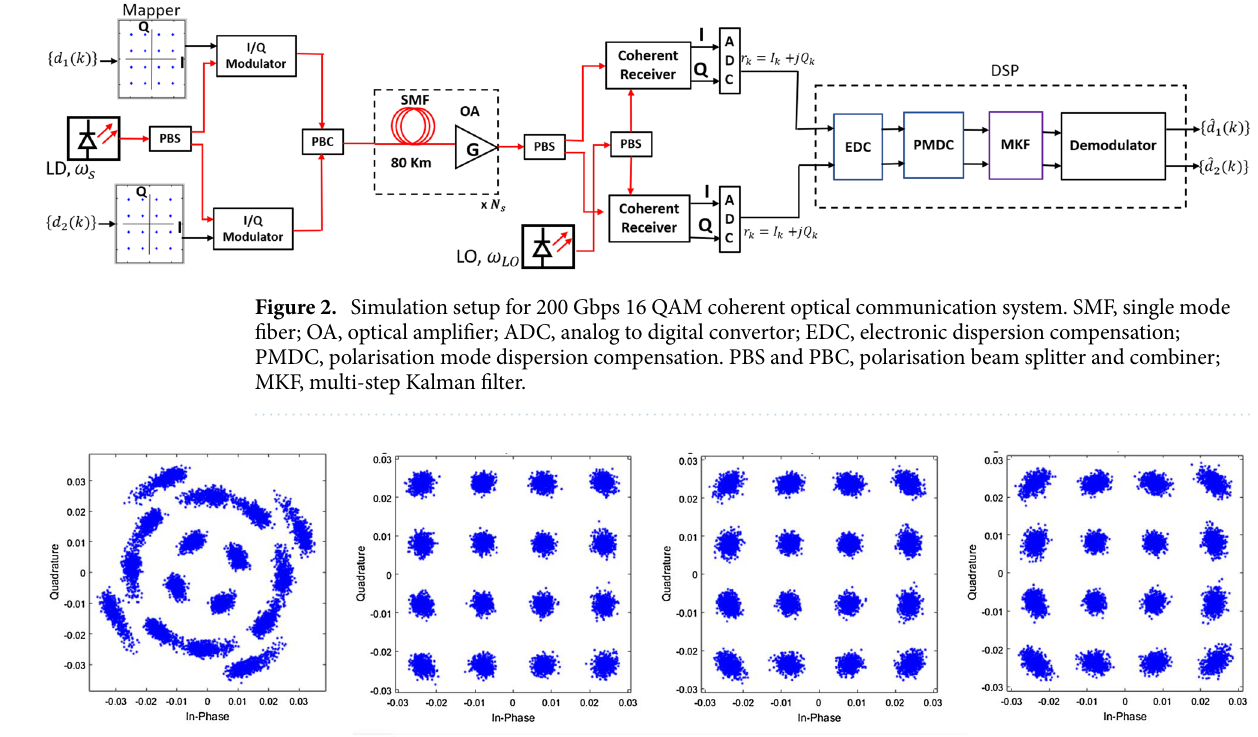
Figure 3. Constellation diagrams of the received signal on P in 1 dBm, N s 12 spans, δν 100 kHz. ( a ) PDM-16-QAM before 1 state MKF, ( b ) PDM-16-QAM after 1 = = = 1 , ( c ) m 10 , ( d ) m 20 state MKF for m = = =